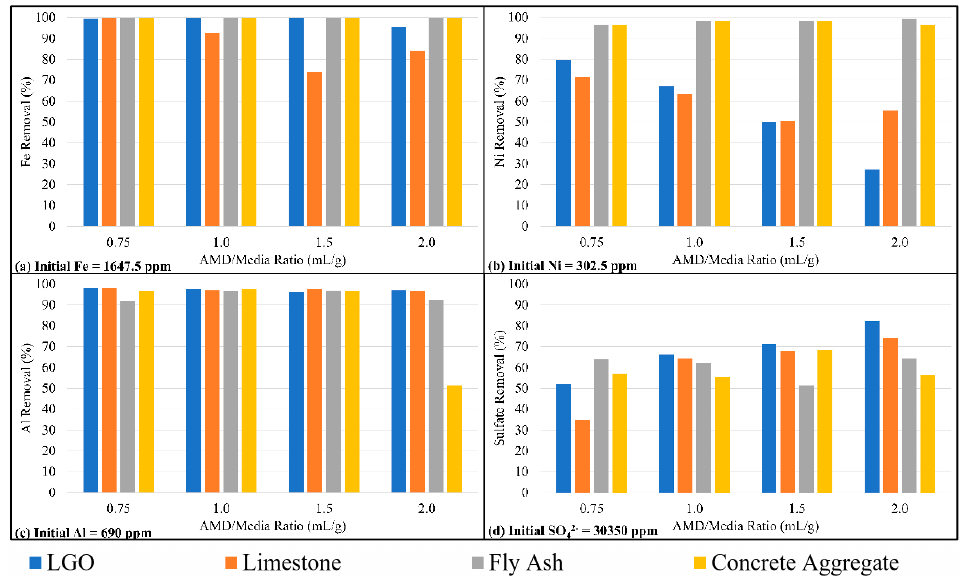
Figure 7. Effect of AMD/Media ratio on the removal of ( a ) iron; ( b ) nickel; ( c ) aluminum; and ( d ) sulfates.